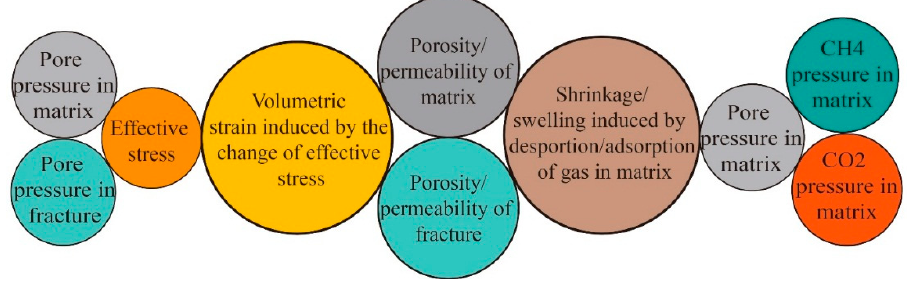
Figure 6. Key factors that control the evolutions of porosity and permeability.